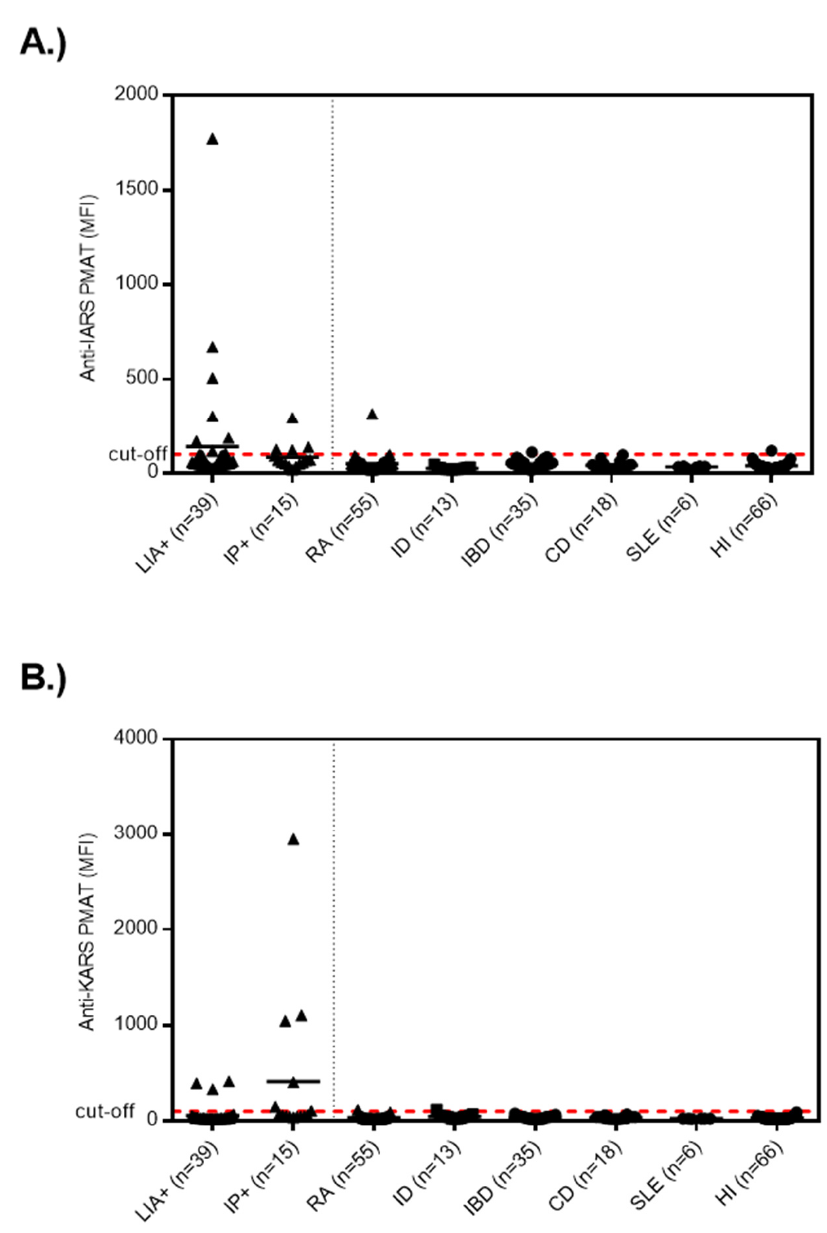
Figure 2. Levels of anti-IARS and anti-KARS reactivity in samples selected either by line im- munoassay (LIA) or immunoprecipitation (IP) and controls . Legend: Samples selected based